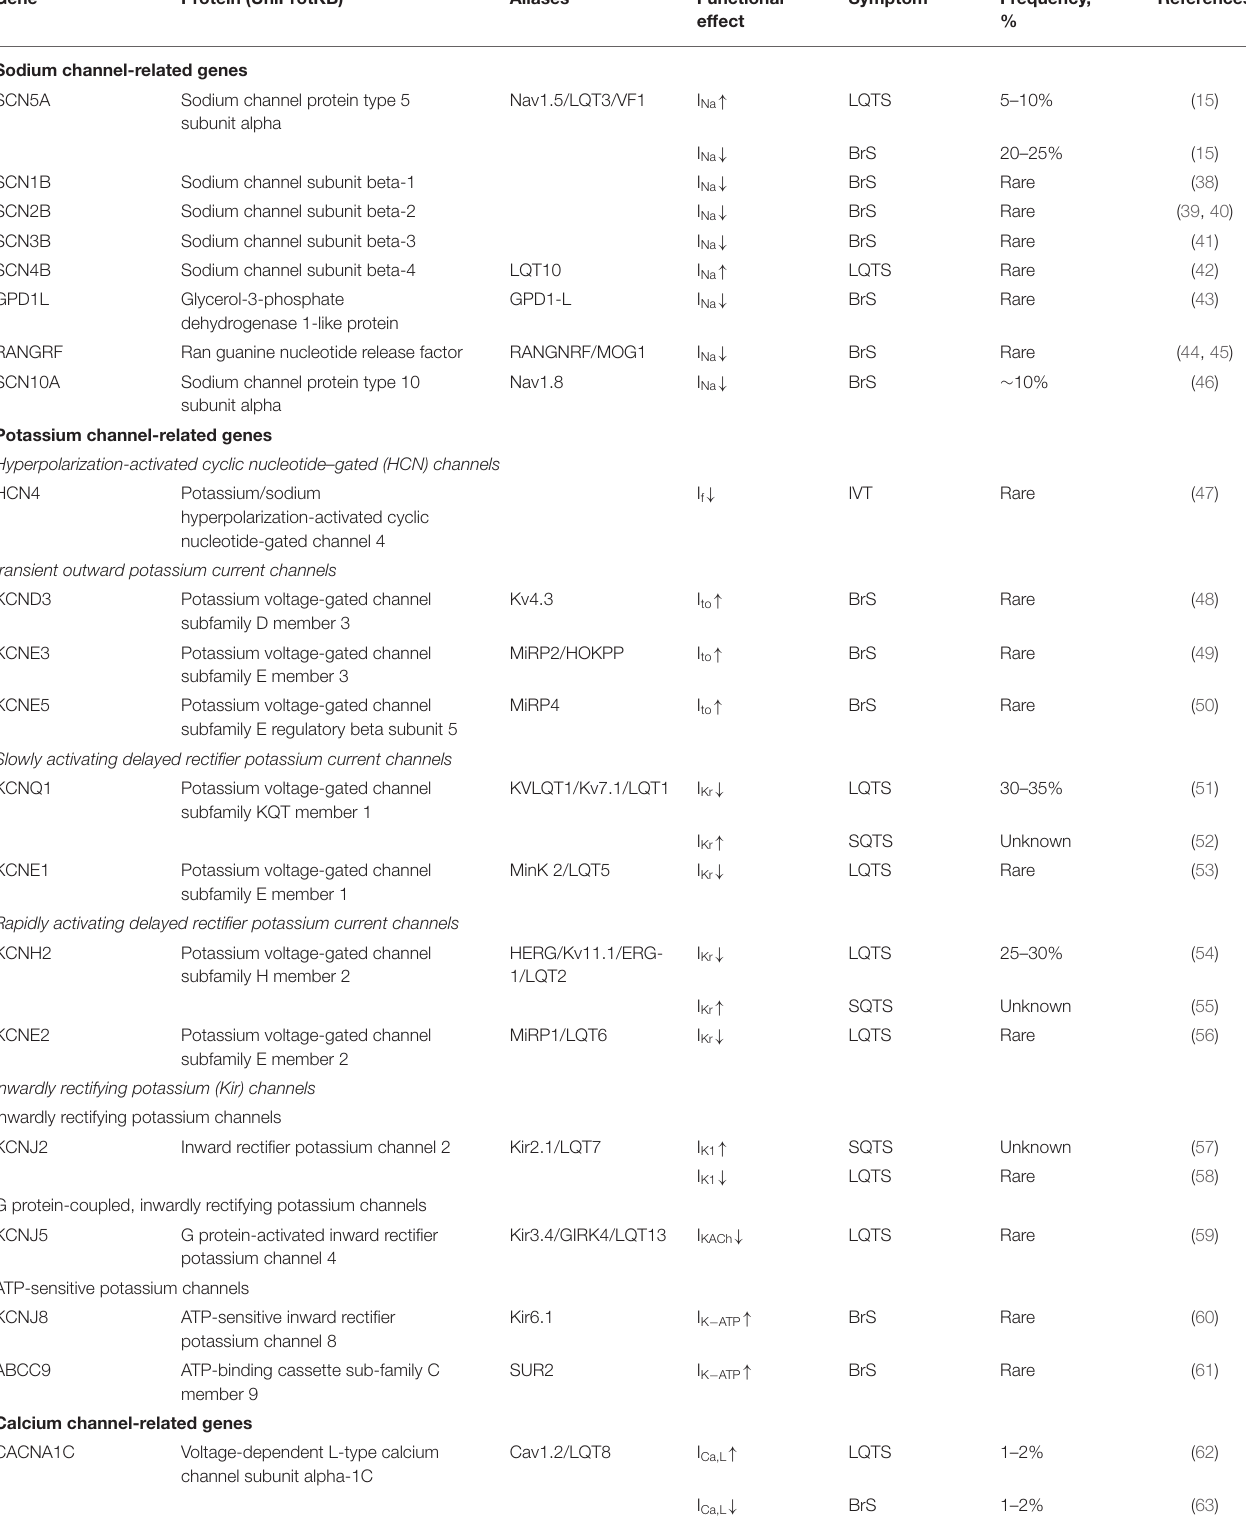
TABLE 2 | Genes associated with ventricular arrhythmias in non-structural heart disease. Gene Protein (UniProtKB) Aliases Functional